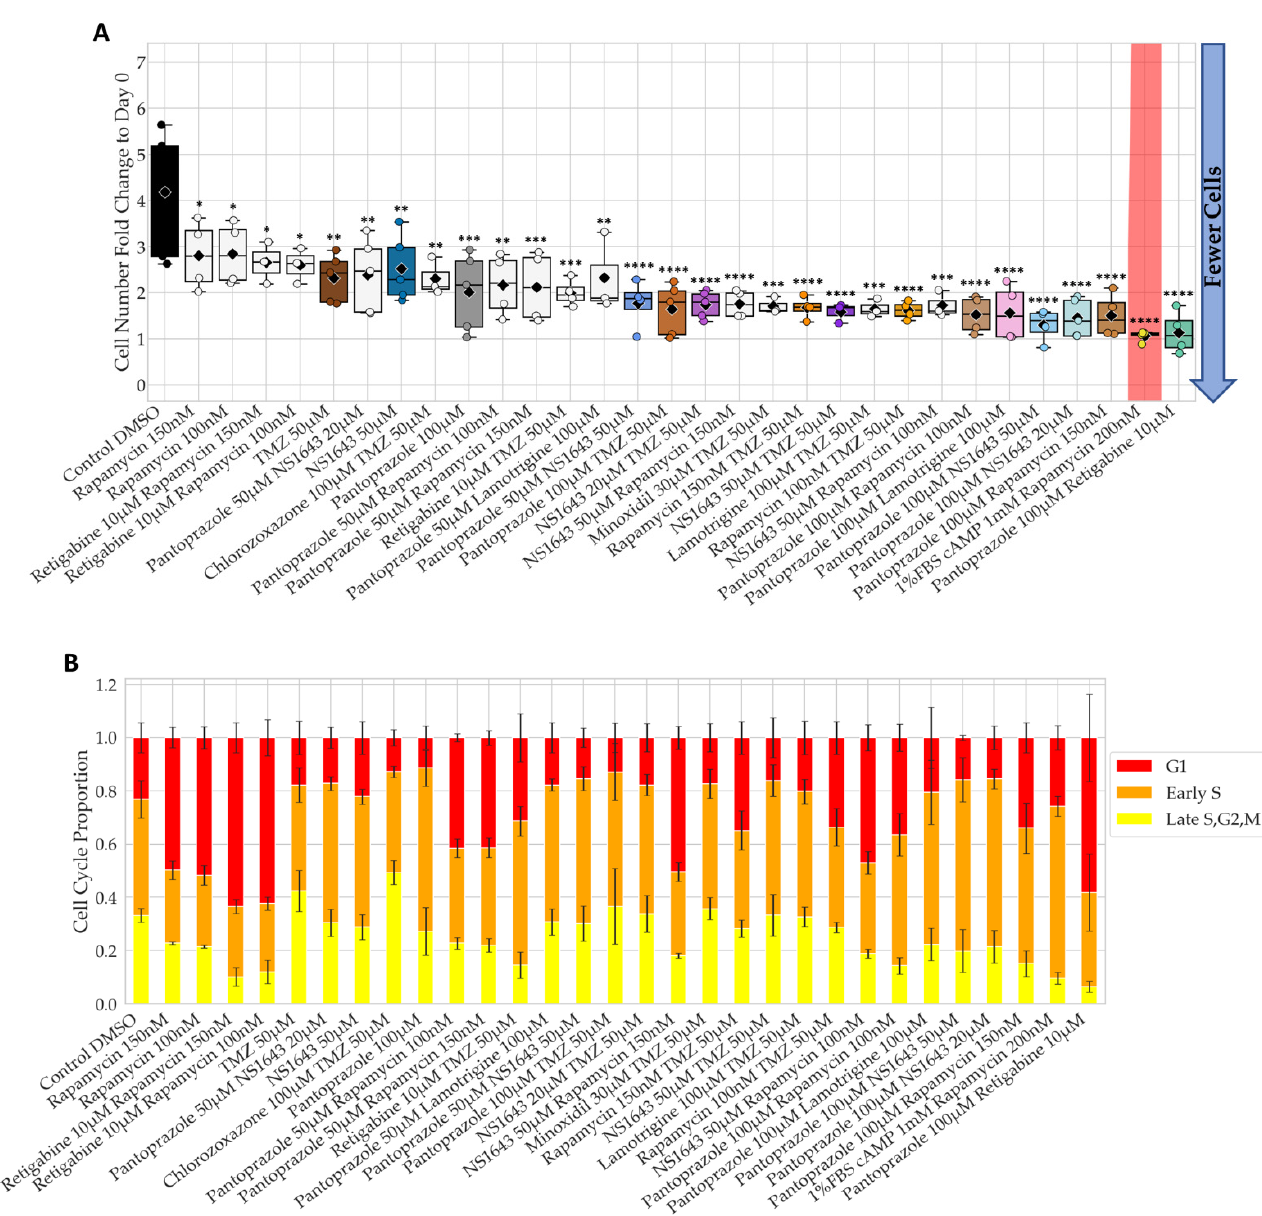
Figure 4. Bioelectric Drugs in Combination with Each Other, Pantoprazole, and TMZ Reduced Proliferation in U87 cells and Changed the Cell Cycle Ratio Compared to Control. ( A ) Fold change to start cell counts (cells at day 6/cells at day 0) after 6 days of treatment. Low values indicate less cell growth. Colors indicate treatments followed up for further analysis and hues represent concentrations and combinations. Red shaded treatment corresponds to positive control that cannot be used clinically. Only treatments with significant values are shown out of 42 treatments compared to DMSO control. ****: q < 0.0001 ***: q < 0.001, **: q < 0.01, *: q < 0.05 (one-way ANOVA with FDR post hoc analysis n > 3 biological replicates). ( B ) FUCCI cell cycle data at day 6. Increased red and orange fractions indicate cell cycle arrest at G1 or G1 to S